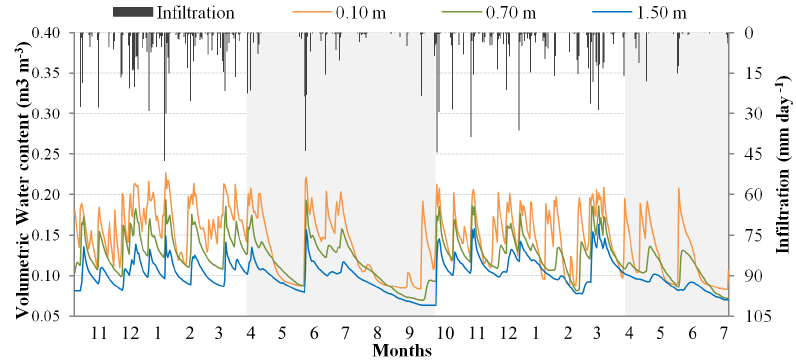
Figure 4. Estimated infiltration and volumetric water content measured at the depth of 0.10, 0.70, and 1.50m. Data were collected from October 2012 to July 2014. The grey shaded bars show the dry